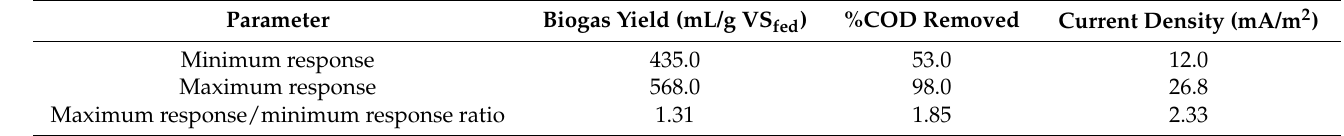
Table 1. Transformation for biogas yield, %COD removed, and current density